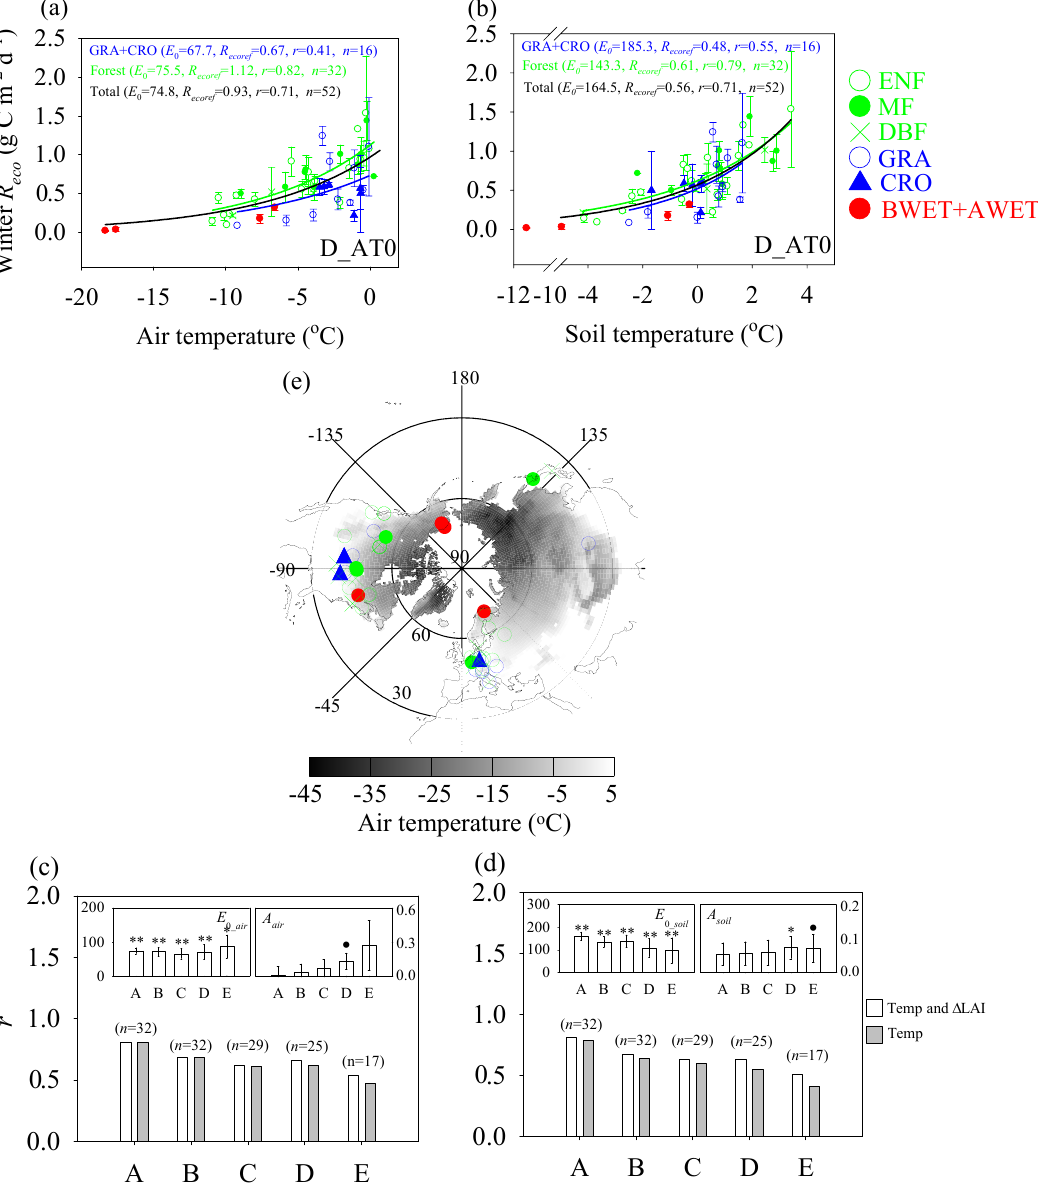
Fig. 4. Relationships between winter air temperature (a), soil temperature (b) and R eco using winter definition D AT0. The coefficient of determination ( r 2 ) between the Arrhenius models with and without 1 LAI is compared using air temperature (c) and soil temperature (d) respectively in the forest ecosystems. A, B, C, D, and E in both (c) and (d) denote winter definitions D TM, D AT0, D AT-2, D AT-5 and D AT-10, respectively. The spatial distribution of eddy covariance sites is displayed in (e) . Winter air temperature from 1 December to 28 February is used as the background in (e) . Significance levels are indicated as **, * and • representing p < 0 . 01, 0.05 and 0.1, respectively.